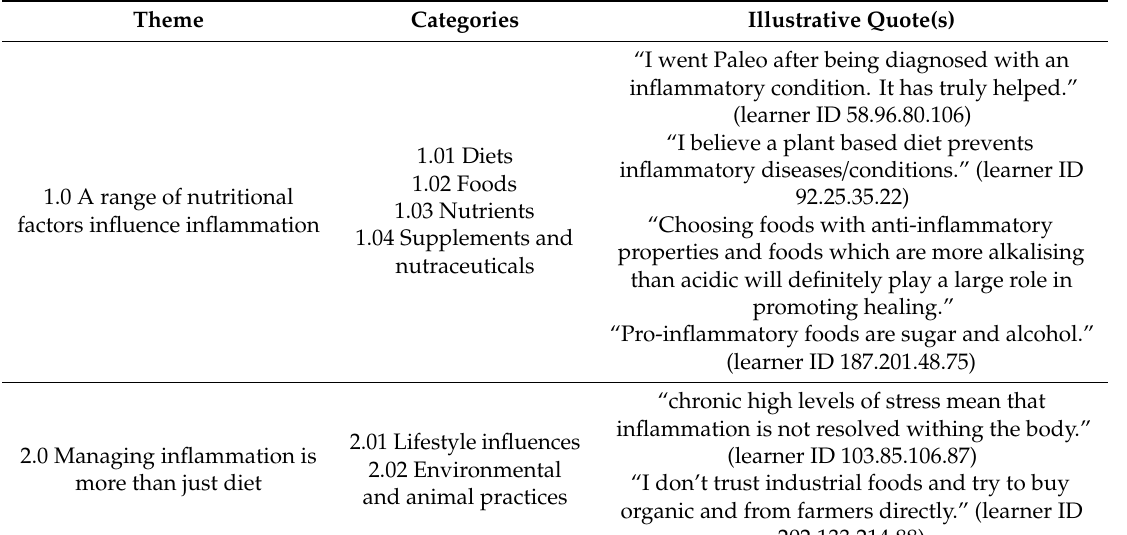
Table 3. Theme summaries, categories and key illustrative quotes generated using the Framework method of qualitative data